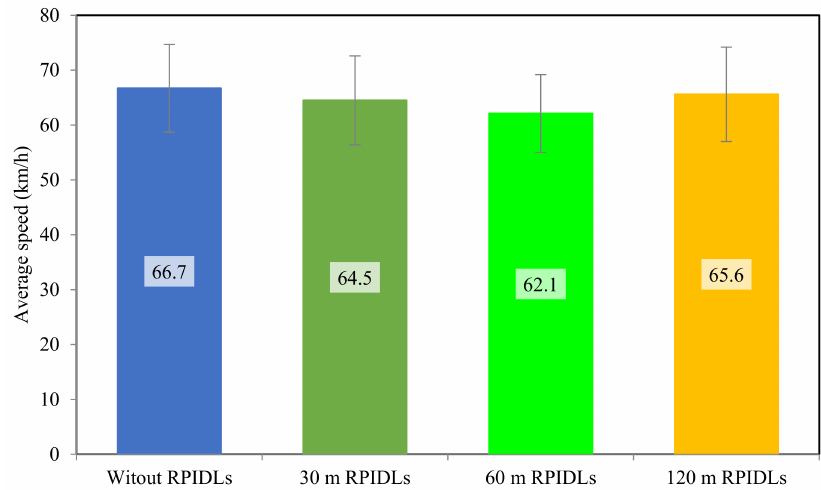
Figure 12. Average speeds and standard deviations of vehicles near tunnel entrance with and without RPIDLs.